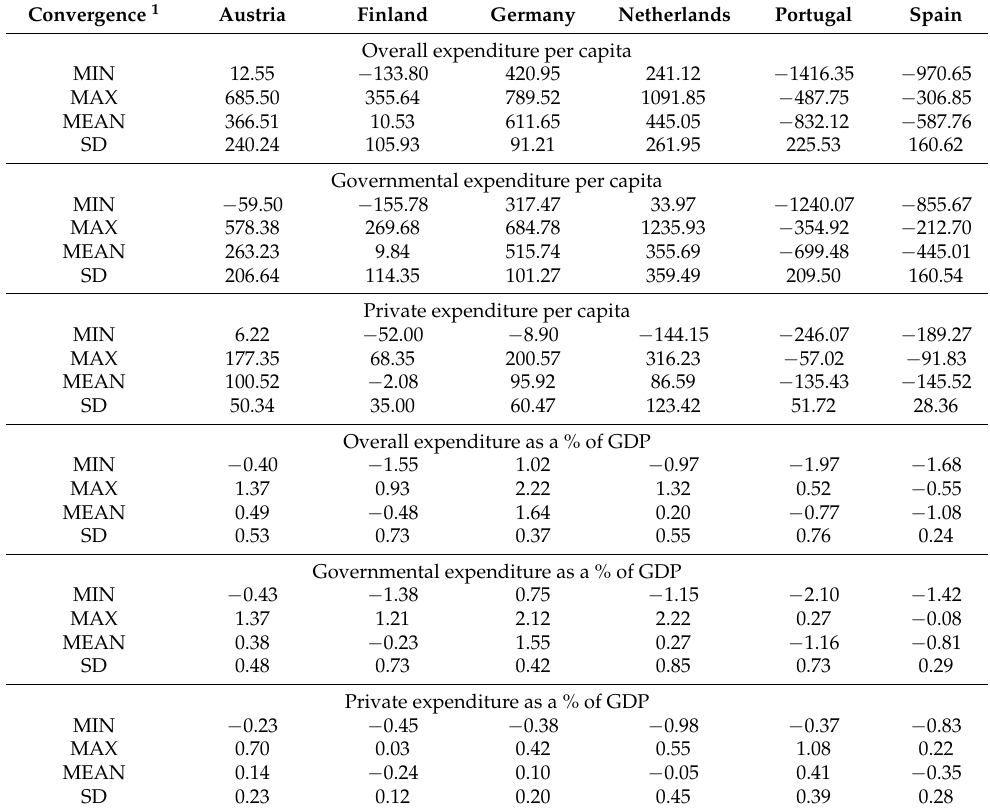
Table 1. Summary